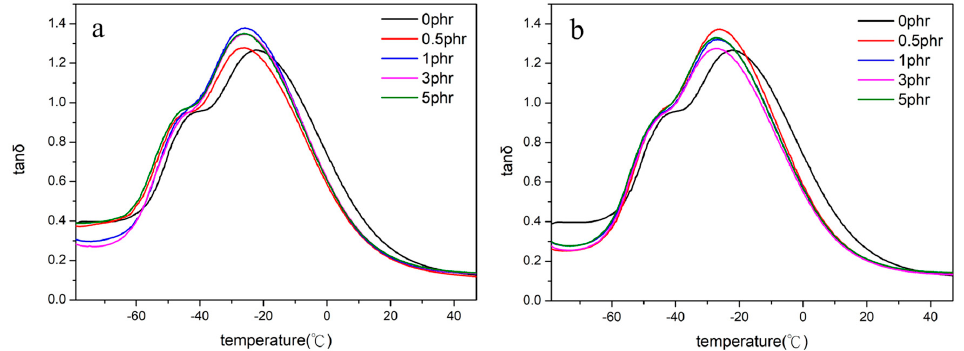
Figure 11. tan( δ ) Measurements: ( a ) MoS 2 -ethanethiol-butyl and ( b ) MoS 2 -nonanethiol-butyl rubber.